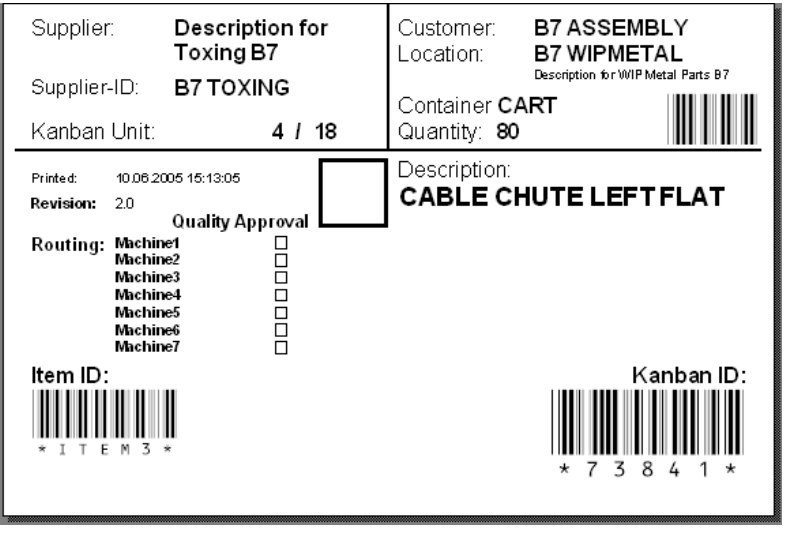
Figure 1. Representation of Kanban Card.